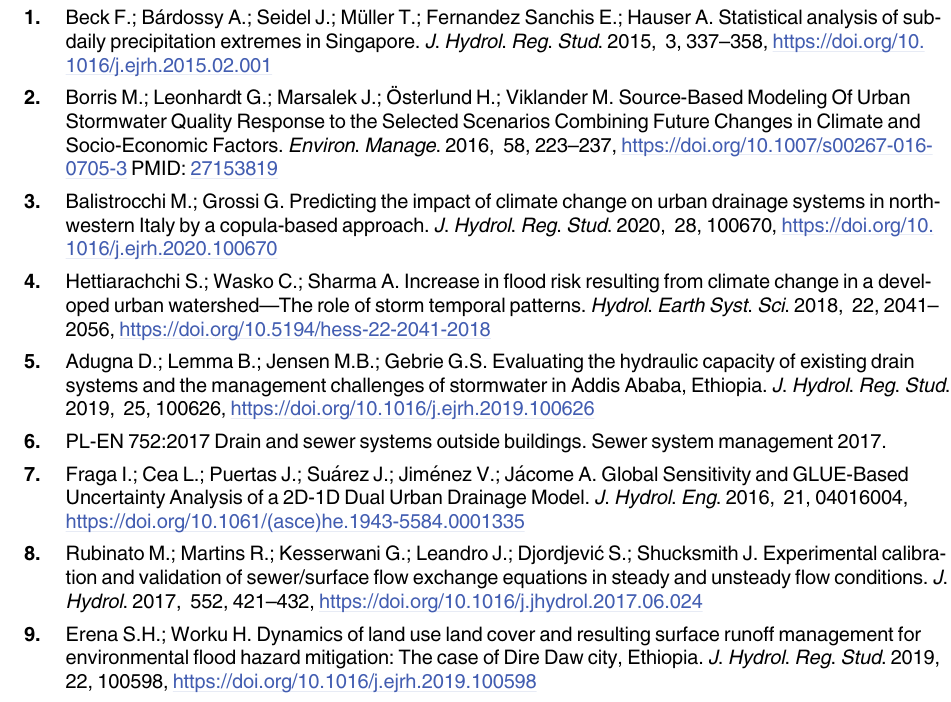
S4 Table. Values of sensitivity indexes (p S5 Table. Regression